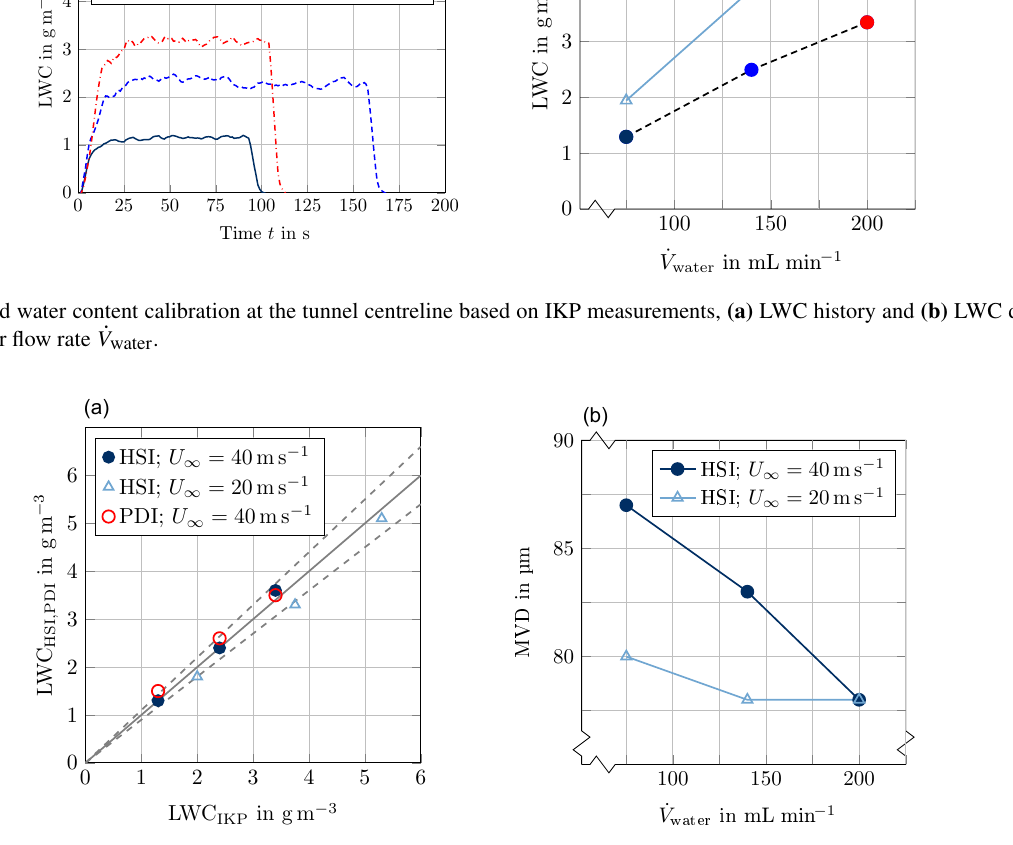
Figure 22. Comparison of HSI, PDI and IKP measurements for supercooled droplet conditions: (a) optical array probes vs. IKP and (b) MVD vs. volumetric flow rate of liquid water at the spray